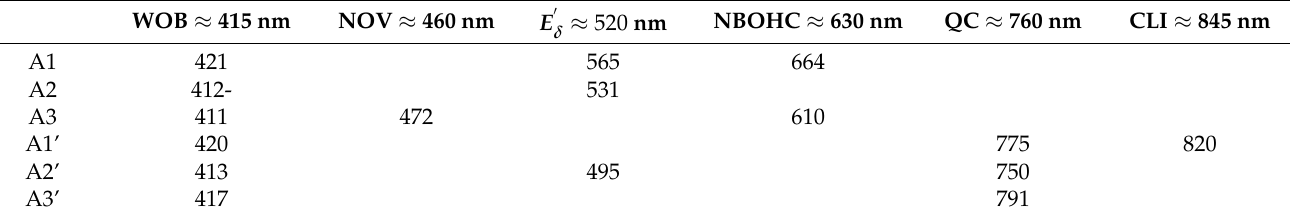
Table 4. PL deconvoluted bands and their proposed source of